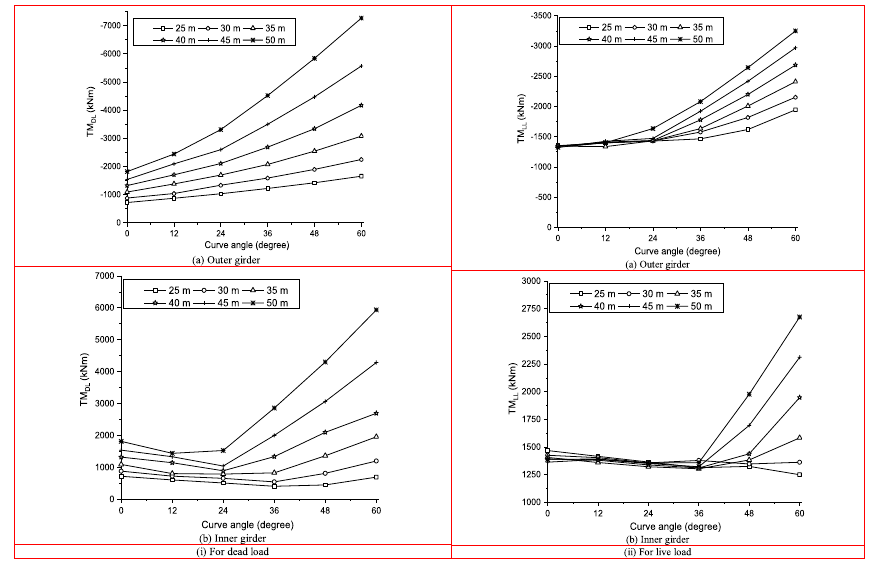
Fig. 11 Variation of torsional moment with curve angle for different span. a Outer girder. b Inner girder. (i) For dead load. (ii) For live load